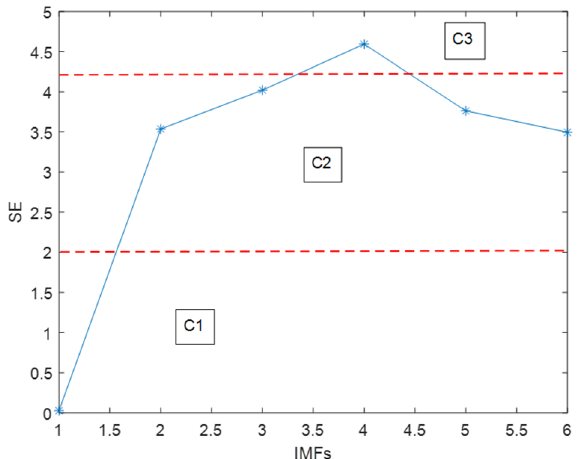
Figure 9. The SEs value corresponding to each intrinsic mode function (IMF).